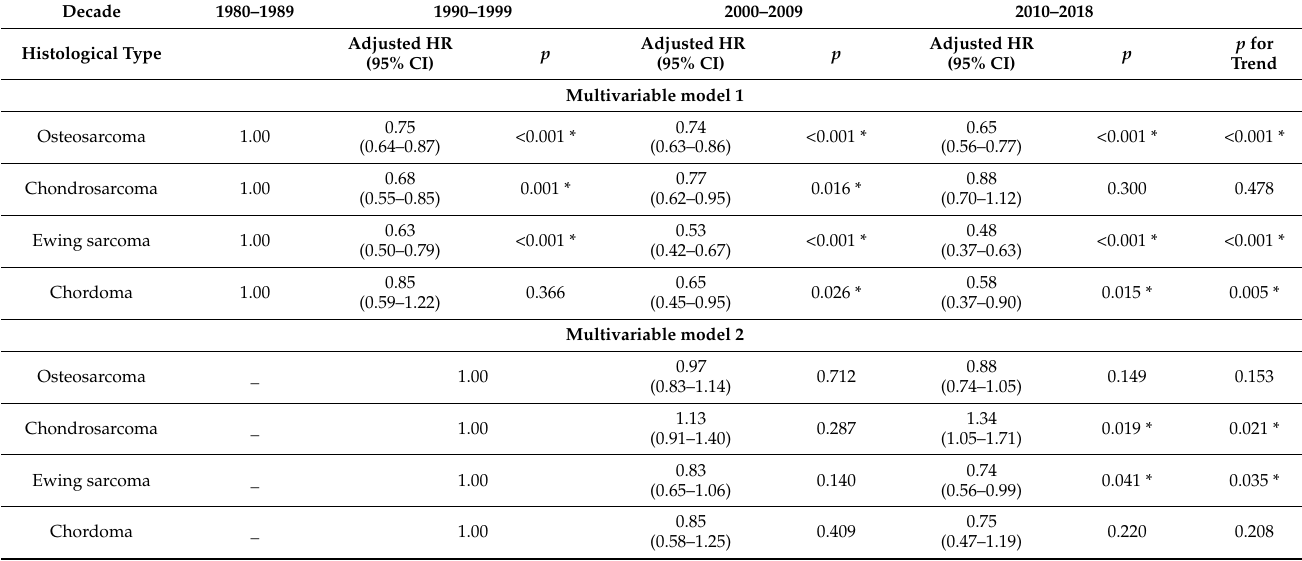
Table 3. Trends in the adjusted HR for CSM in specific histological types.